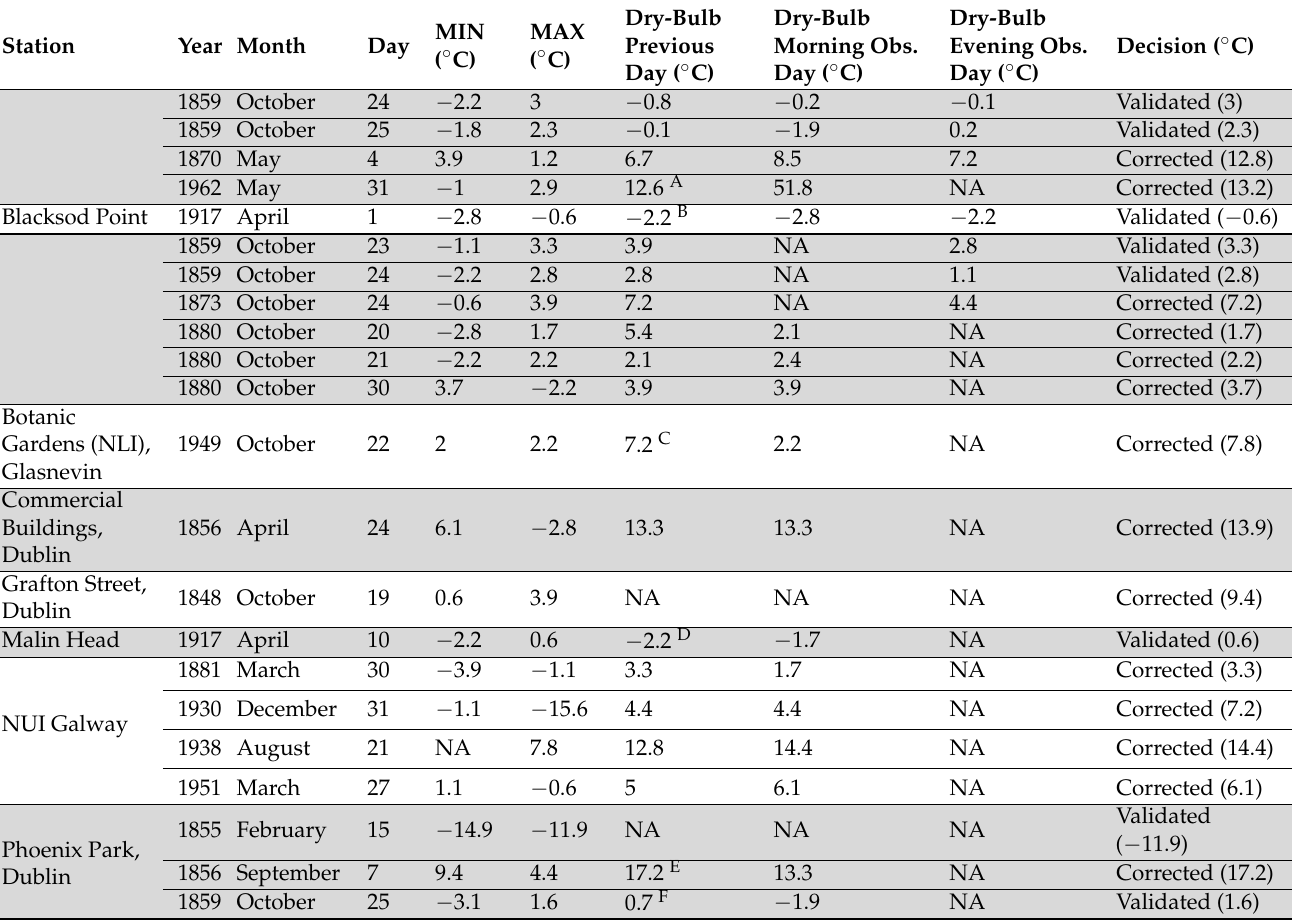
Table A3. Flagged lower daily MAX threshold exceedance (flag 3) and the dry-bulb thermometer registered on previous and observation days.